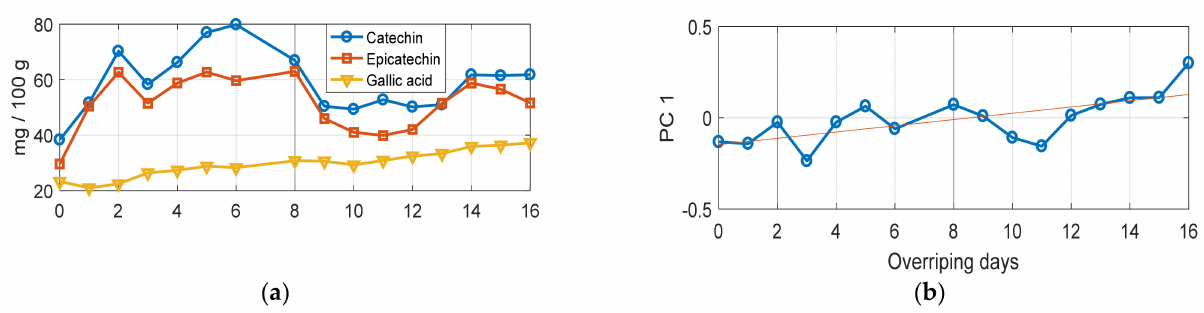
Figure 5. ( a ) Evolution of the major phenolic compounds identified in ZA grape seeds during the overripeness process (16 days of postharvest sun drying). ( b ) Temporal behavior of daily means for the PC1 score. All variables were auto-scaled to allow a comparison of